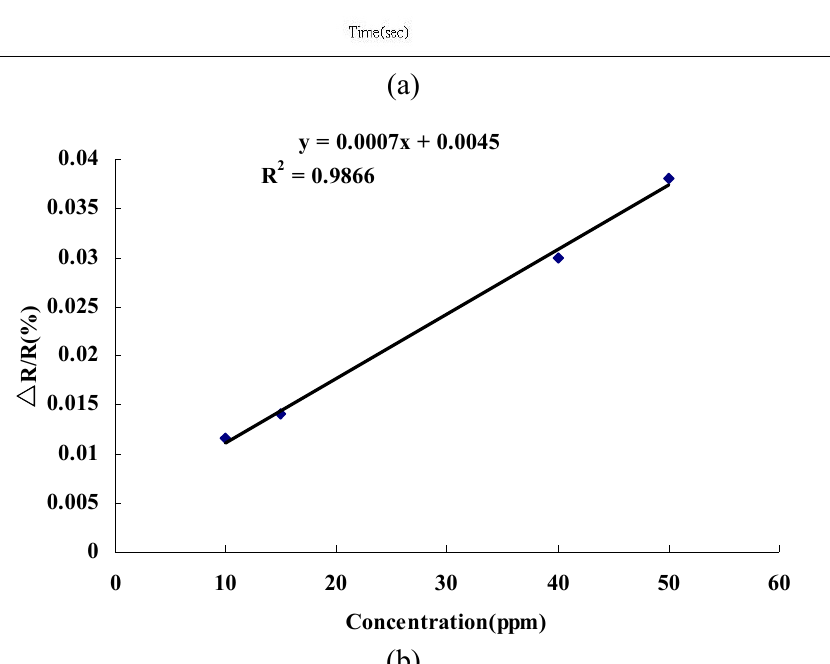
(a) y = 0.0007x + 0.0045 R 2 =